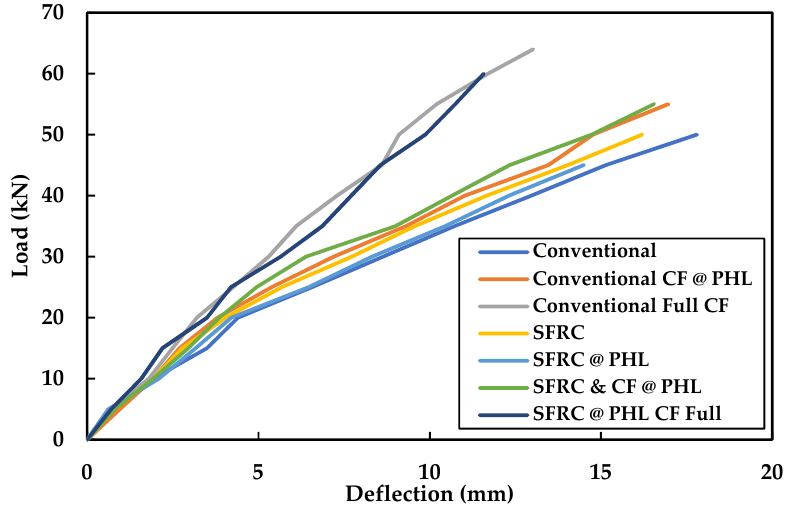
Figure 11. Analytical load-deflection curve.